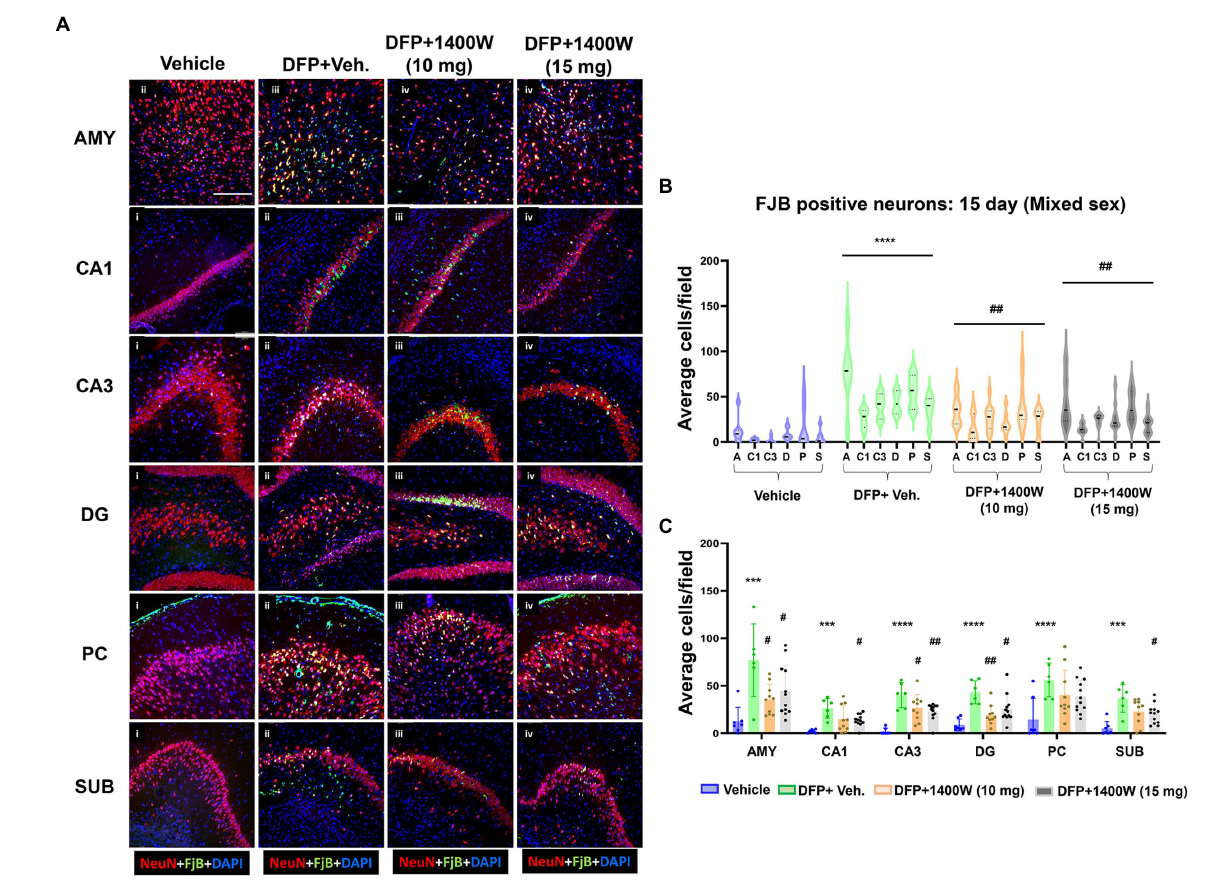
FIGURE 6 The effects of 1400W treatment for 2 weeks on neurodegeneration. Representative images of NeuN (red, for neurons) and FJB (green) positive cells from Amygdala (AMY), CA1, CA3, Dentate gyrus (DG), Piriform Cortex (PC), Subiculum (SUB) regions are shown. Co-localized (orange) cells represent degenerating neurons. Sections were counterstained with DAPI (blue) to represent all nuclei, scale bar = 50 μ M (A) . Mixed effects model revealed a significant increase in degenerating neurons in brain as a whole in DFP + vehicle group at 15 days post-exposure (B) .The two-way ANOVA analysis showed an increase in FJB positive neurons within different regions of the brain following DFP exposure and 1400W treatment significantly reduced the DFP induced increase in FJB positive neurons at 10 mg/kg in AMY, CA3 and DG, while 15 mg/kg reduced in all regions except the PC (C) , n = 7–12. Repeated measure Two-way ANOVA (mixed effects) with Tukey’s post-hoc for multiple comparisons. * Represents DFP effect compared to vehicle (control); # represents the 1400W effect compared to DFP + vehicle group * represents DFP effect compared to vehicle (control) and #